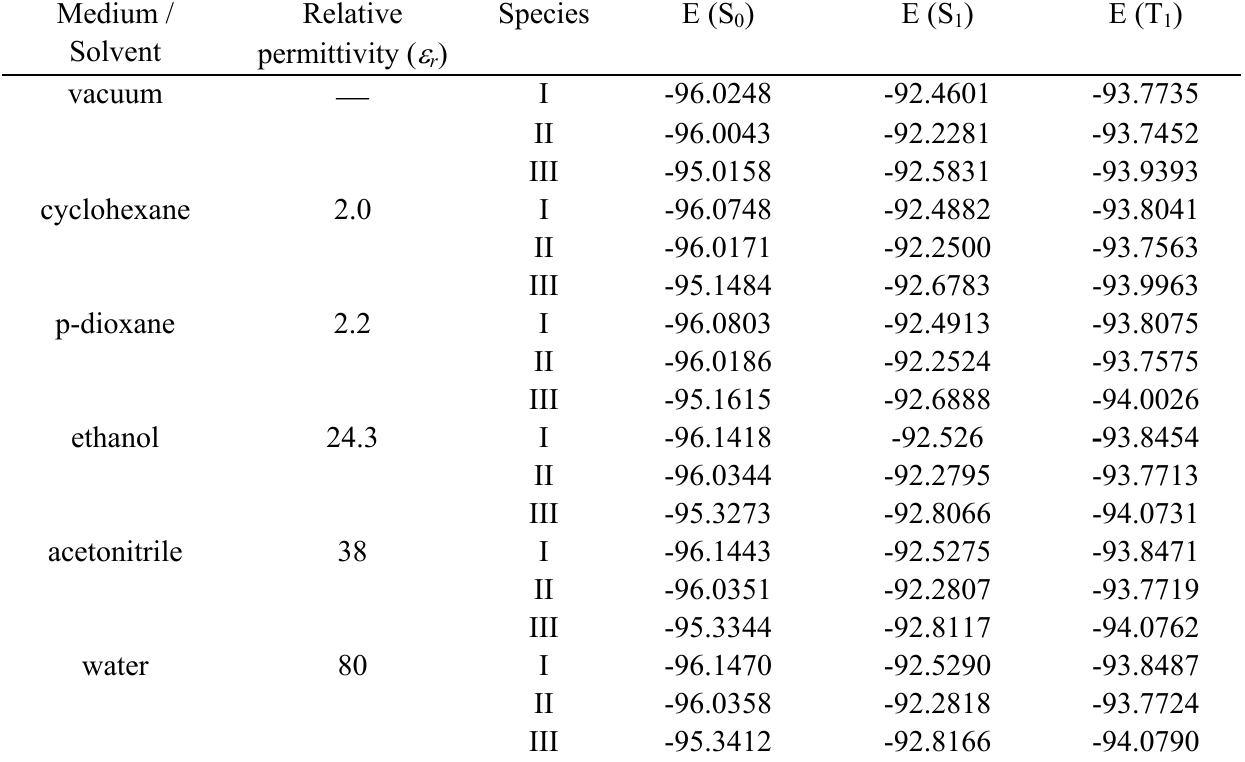
Table 7. Calculated S , S and T energies (eV) of the normal (I), rotamer (II) and tautomer (III) of 0 1 1 HPI in isolated and solvated conditions (Onsager’s cavity radius, a = 4.23 Å). Medium